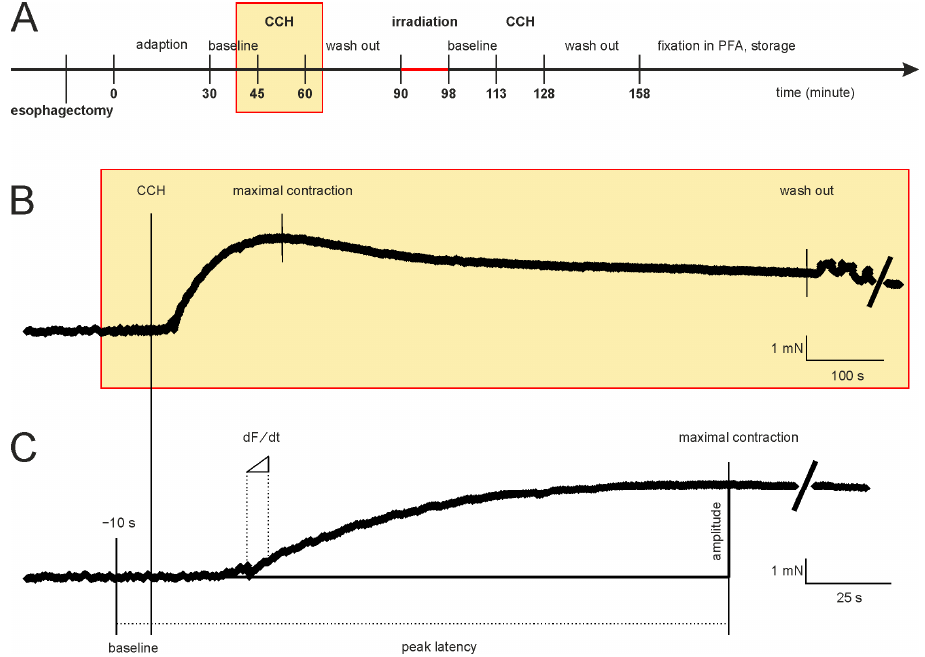
Figure 1. Time course of the experiments and a representative measurement of the contraction force of an esophageal segment. ( A ) Initially, the segments adapted for 30 min to establish stable conditions. Subsequently, the baseline tone, the CCH-induced contraction (yellow rectangle), and the relaxation time (following washout) were registered before and after irradiation. ( B ) Sample recording of the CCH response for 15 min. ( C ) This panel is a section of the force-time diagram of B. Shown is the time interval from the CCH-induced contraction to maximum force. The calculated functional parameters are shown. Abbreviations: CCH = carbachol (adding into the organ bath).